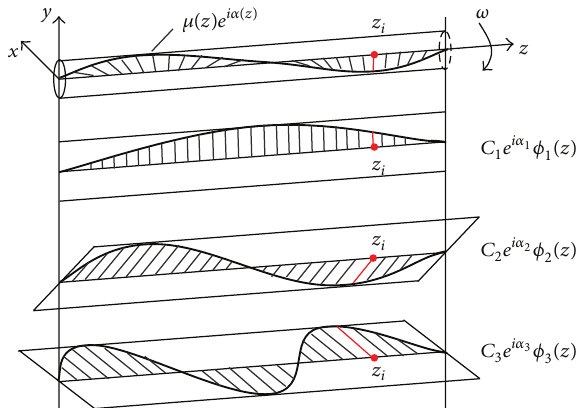
Figure 1: The general first three modal shapes of rotor-bearing